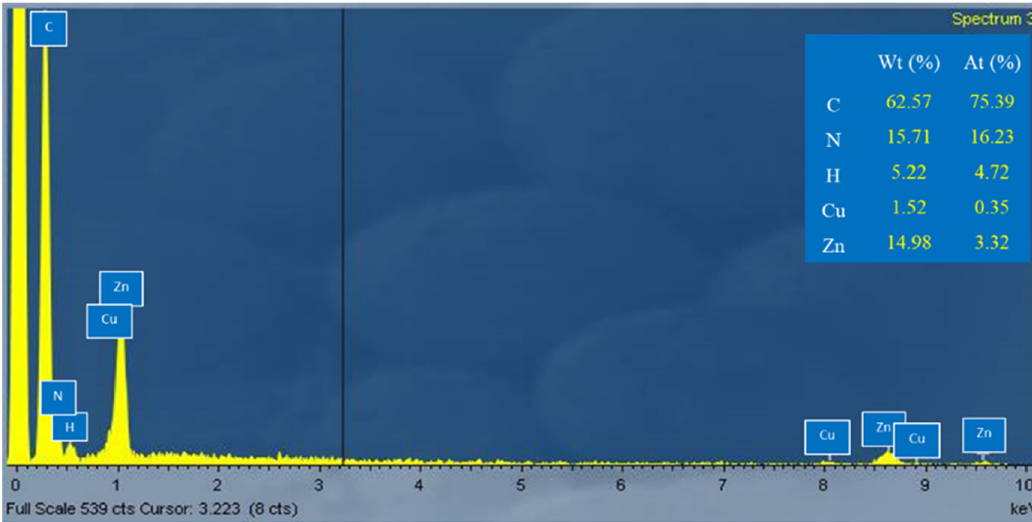
Figure A5: EDX spectra of CuZn - ZIFs.